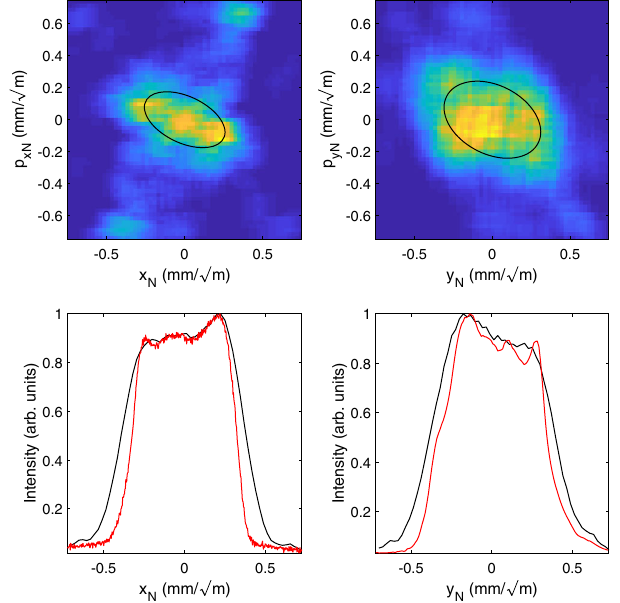
FIG. 6. Results from phase space tomography in CLARA FE, treating horizontal and vertical phase spaces separately. The top plots show the charge density in the beam at SCR-02 in the horizontal (left) and vertical (right) phase spaces, in normalized variables (co-ordinates scaled by the square root of the beta function). The black ellipses show the emittance ellipses obtained by fitting a two-dimensional Gaussian to each phase space distribution. The bottom plots show the density projected onto the horizontal (left) or vertical (right) axes: black lines are from the tomographic reconstruction, red lines are from direct obser- vation of the beam image on